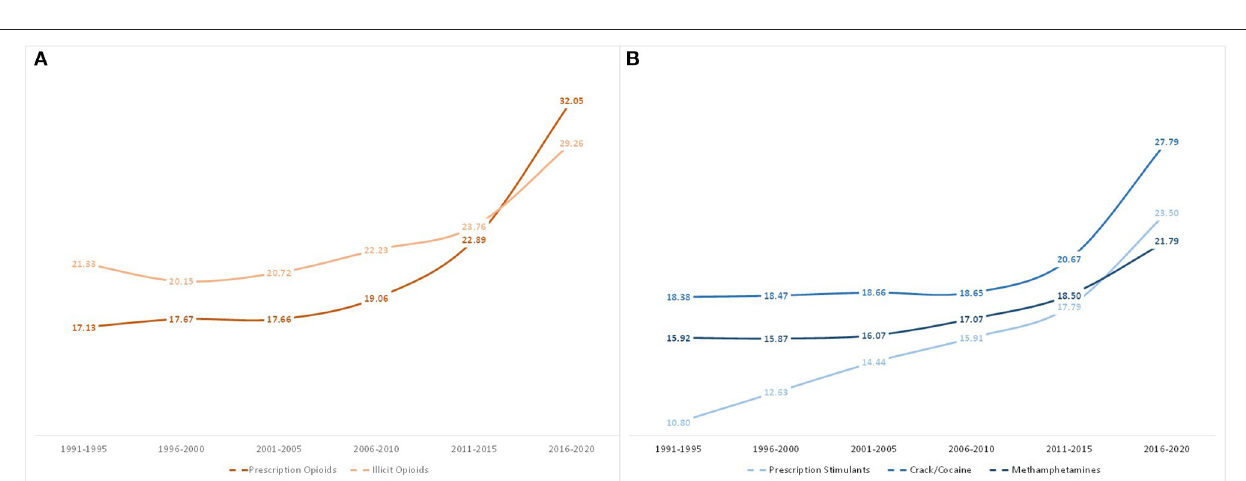
FIGURE 5 | Types of opioids and stimulants used in the year of initial drug exposure. Total percentage may exceed 100% as multiple drugs may have been used in the year of initial drug exposure.